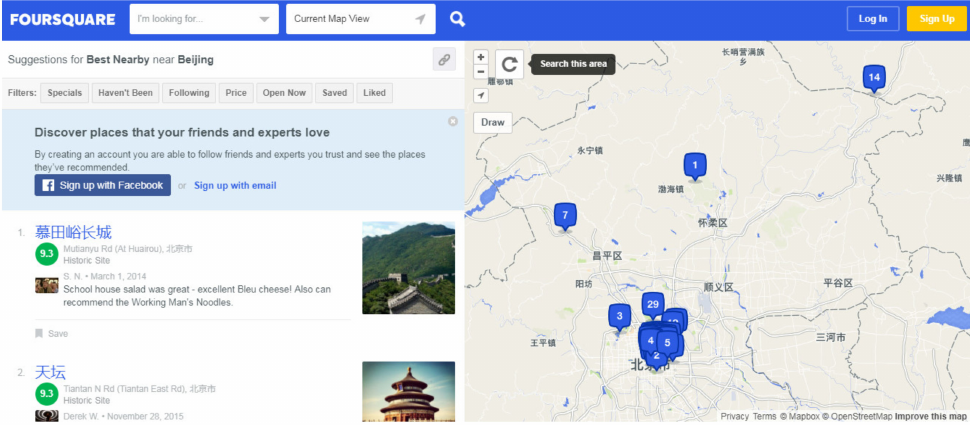
Figure 5. Foursquare website.